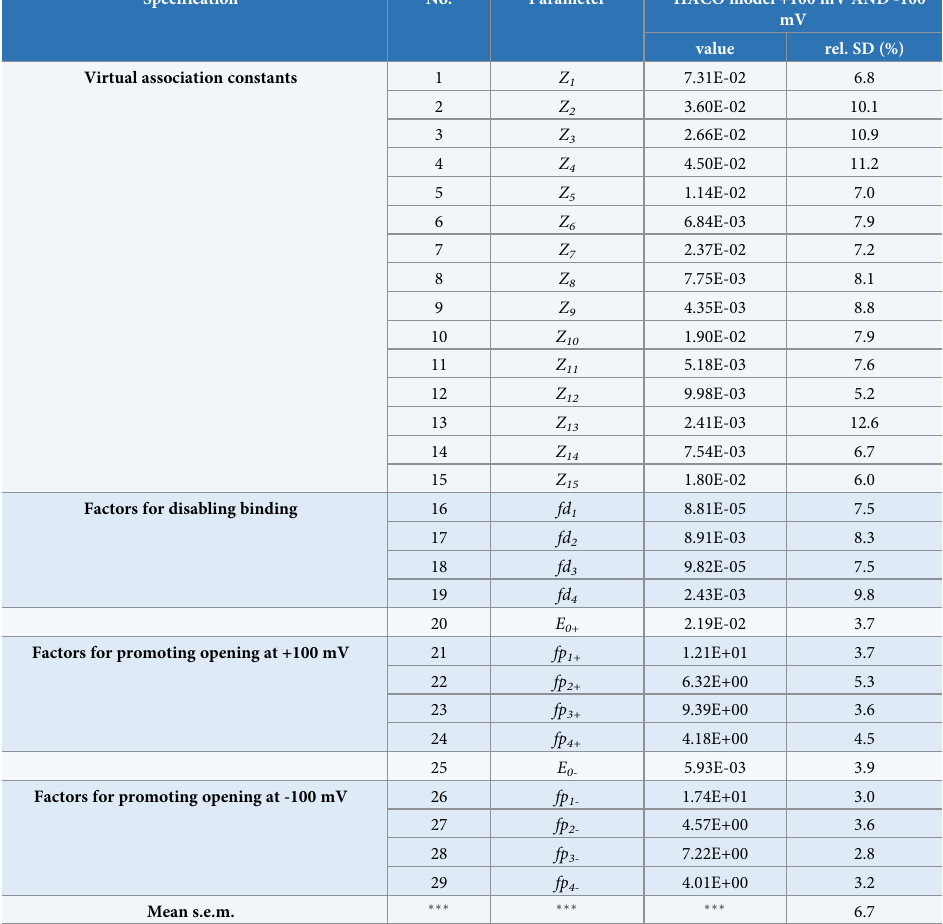
Table 1. Fit parameters of the global fit with the 29 HACO model at +100 mV AND -100 mV. The dimensions